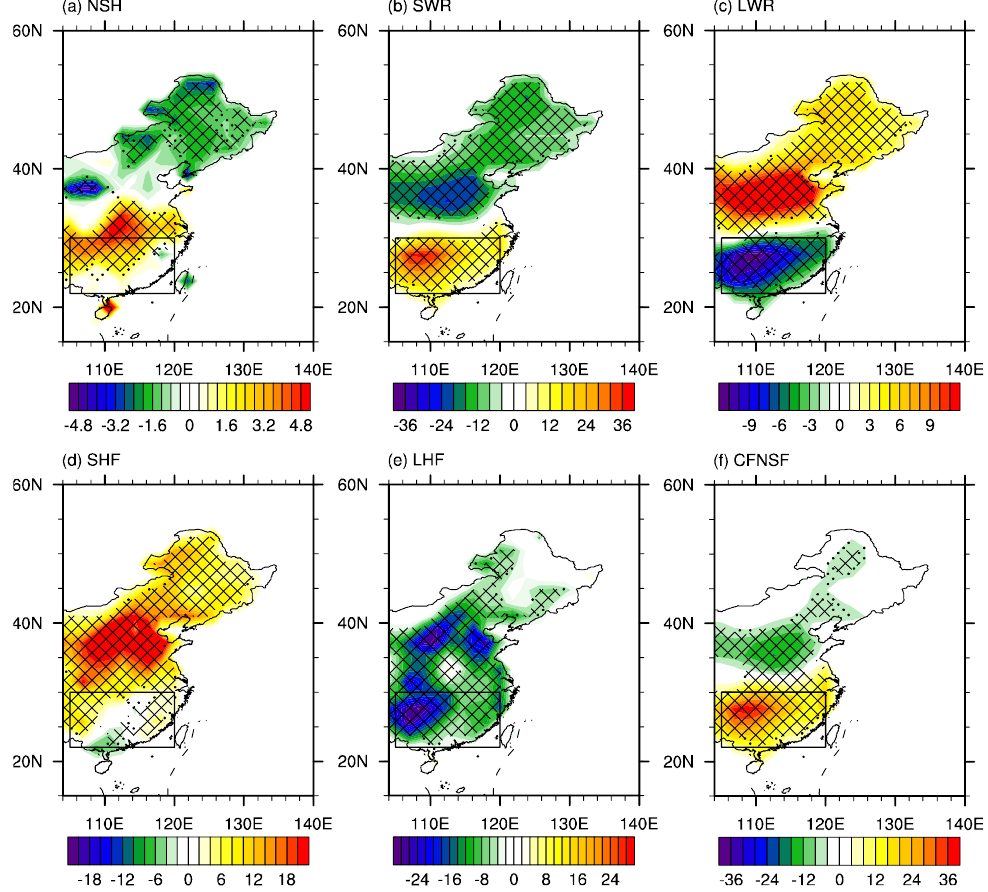
Figure 3. The composite anomalies of summer mean ( a ) net surface heat flux (NSH), ( b ) surface net shortwave radiation (SWR), ( c ) surface net longwave radiation (LWR), ( d ) surface sensible heat net flux (SHF), ( e ) surface latent heat net flux (LHF), and ( f ) cloud forcing net solar flux (CFNSF) based on the 267 regional EHEs over southern China (unit: W m − 2 ). The positive direction is defined as downward. Dots and meshes in ( a – f ) denote where the anomalies are significant at the 90% and 95% confidence levels based on Student's t -test, respectively. The black rectangle in ( a – f ) refers to the domain of southern China.